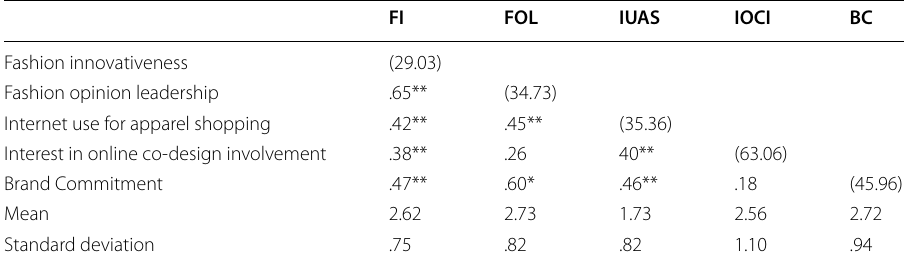
Table 2 Correlation Analysis among the Key